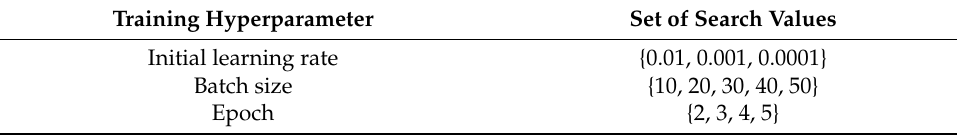
Table 8. Search sets of training hyperparameters to be optimized.